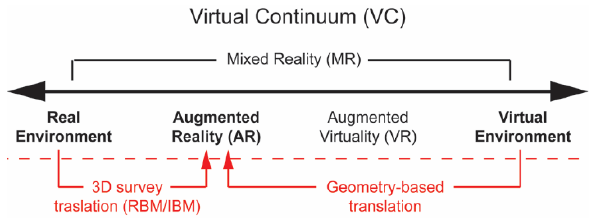
Figure 1: Miligram and Kishino’s schema integrated with two different translation paths towards AR output referred to architecture